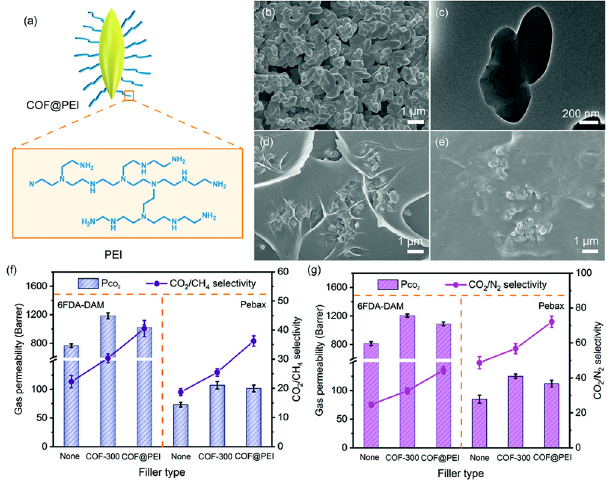
Figure 23. ( a ) Illustration of the PEI grafting on the surface of COF-300 in COF@PEI. ( b ) FESEM and ( c ) TEM images of COF@PEI particles. Membrane cross-sectional FESEM images of ( d ) COF@PEI/6FDA-DAM-7 and ( e ) COF@PEI/Pebax-10 MMMs. ( f ) CO 2 /CH 4 and ( g ) CO 2 /N 2 separation performance of pure polymeric membranes and MMMs containing different fillers. Reprinted with permission from [226], The Royal Society of Chemistry, Copyright (2019).